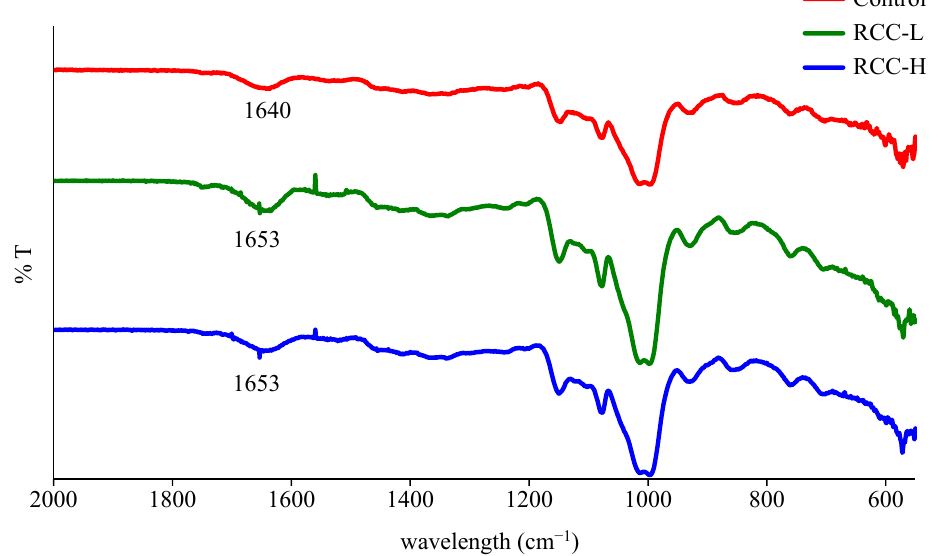
Figure 1. FT-IR spectra of different rice samples.